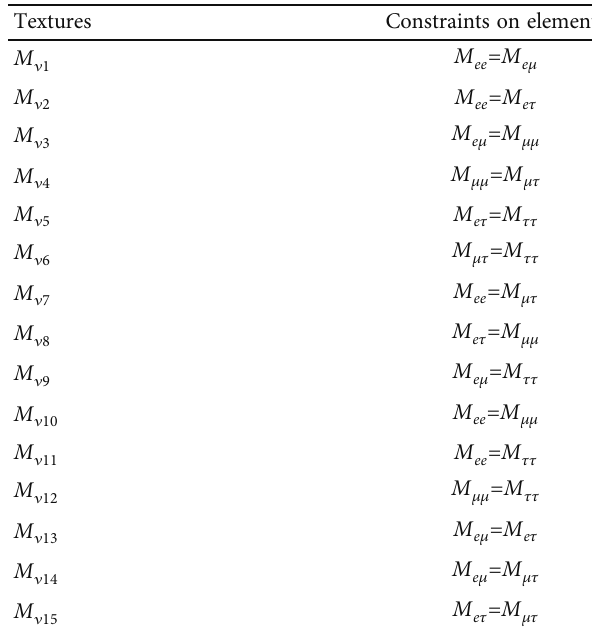
Table 1: Fifteen possible texture structures with one equality between two nonzero